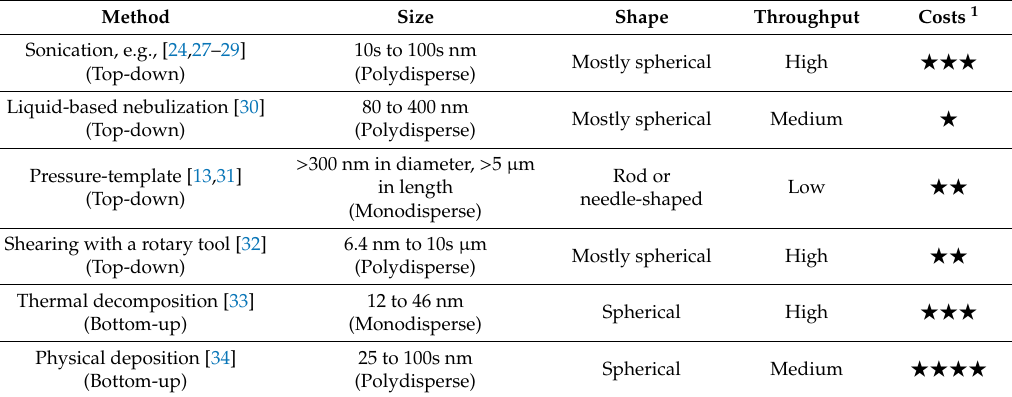
Figure 2. Methods developed for producing biofunctional LMNPs. ( A ) Schematic showing sonicating bulk liquid metal within a solution containing grafting molecules for one-step production of biofunctional LMNPS. ( B ) Schematic illustrating the liquid-based nebulization method for producing LMNPs. Reproduced with permission from Wiley [30]. ( C ) Scheme showing the preparation of rod-shaped LMNPs through the pressure-filter-template method. Reproduced with permission from ACS [13]. Table 1. Comparison of methods for the production of liquid metal nanoparticles (LMNPs).